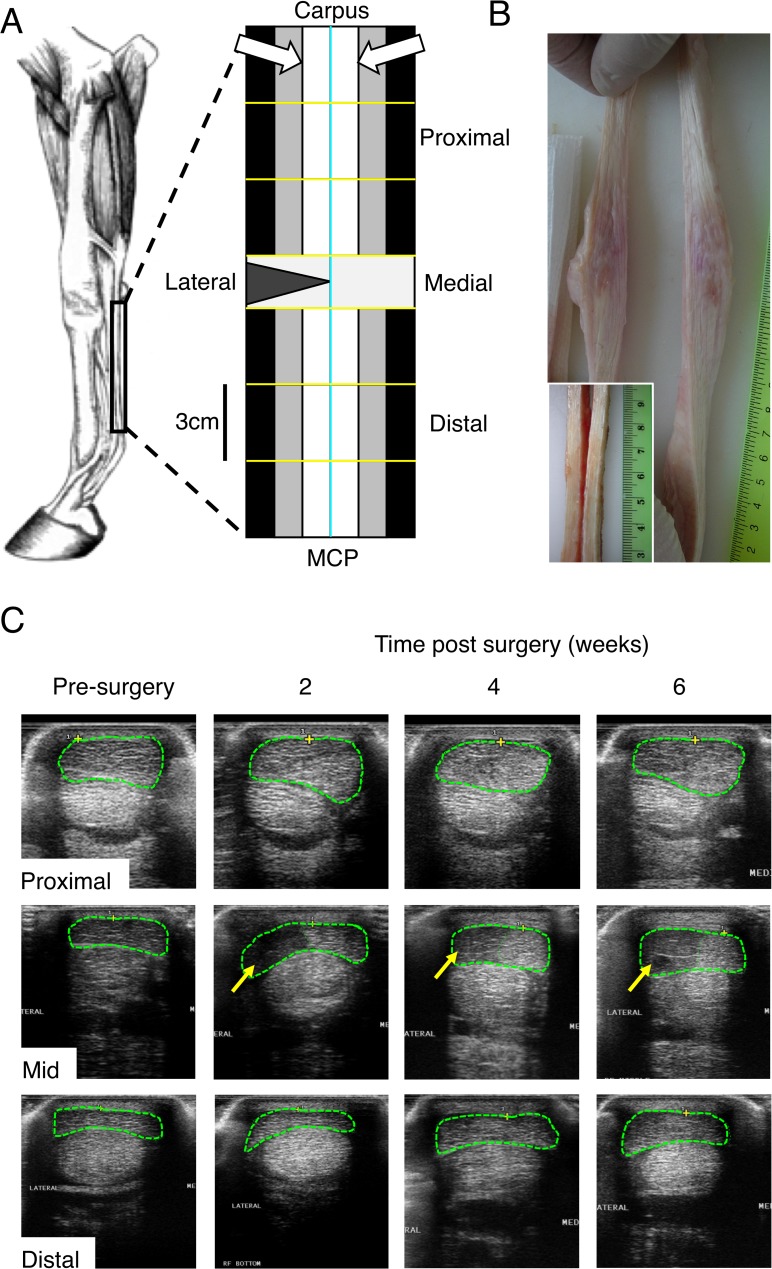
Transection details and ultrasound.A) Schematic diagram of the equine forelimb showing the metacarpal region of the superficial digital flexor tendon (SDFT; width not to scale) used in this study. The tendon was divided into 12 regions; longitudinally lateral and medial (cyan line) and the 1–4cm, 4–7cm and 7–10cm proximal and distal to the midmetacarpal (yellow lines; transection/lesion site indicated by the triangle). Each region was then further longitudinally divided into three portions for different analyses; gene expression (black), biomechanics (grey; not presented here) and histology (white). The histology sections are viewed from the face of the tendon indicated by the white arrows. B) Gross morphology of a representative transected tendon at harvest, six weeks after surgery presented at the same vertical scale (ruler shows cm) as in A) Inset is a control tendon at the lesion area for comparison. C) Ultrasonographs of the operated SDFT of one horse pre-surgery and two, four and six weeks post-transection at three indicated locations along the tendon. The SDFT is outlined with green dashes with areas of hypoechogenicity indicated with arrows.